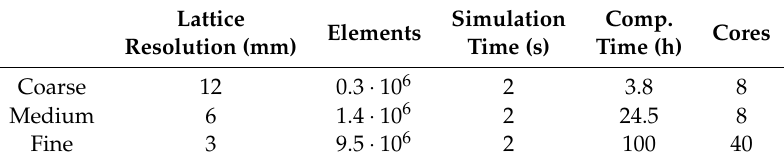
Figure 13. Dynamic stall grid convergence. Table 4. Grid independence with k =